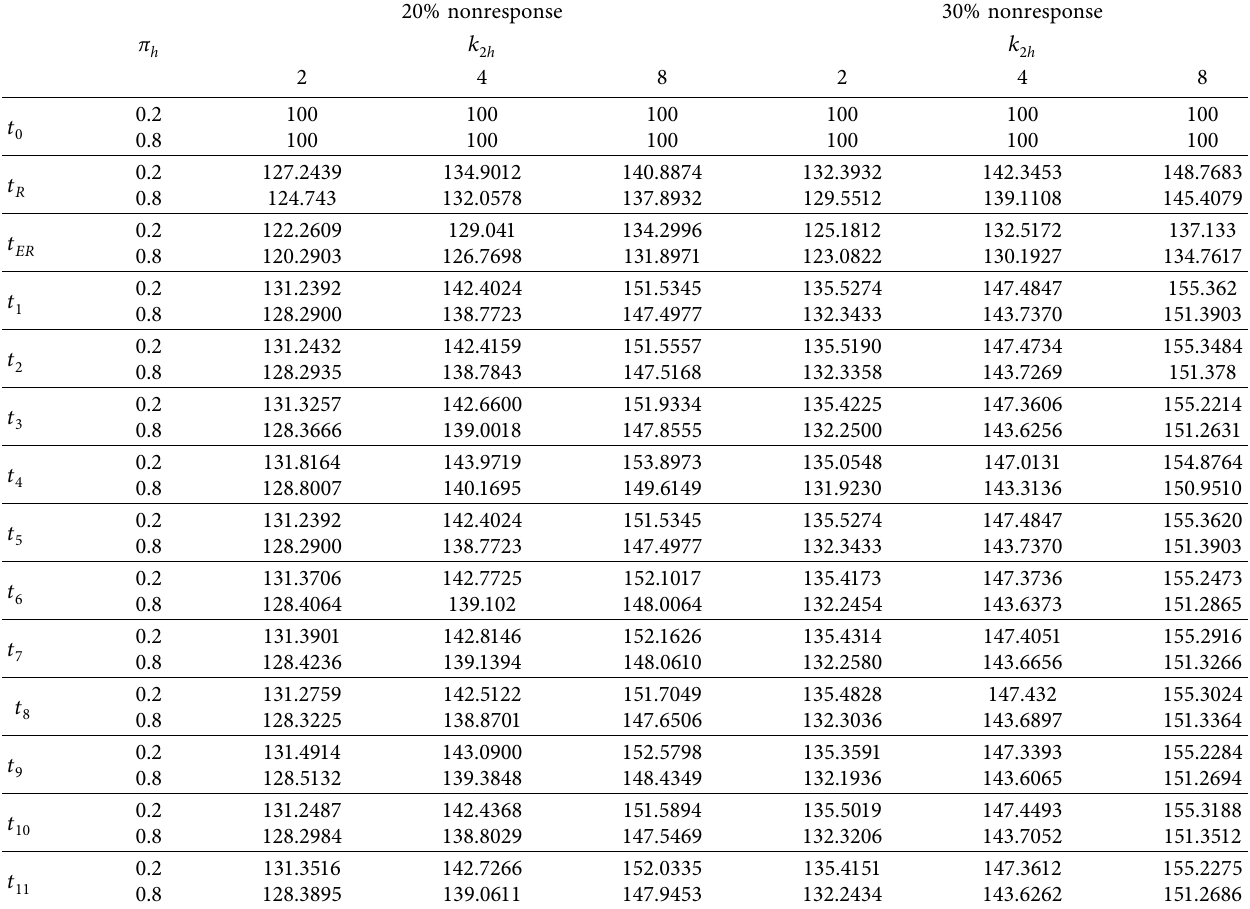
Table 6: PREs of different mean estimators for population II.